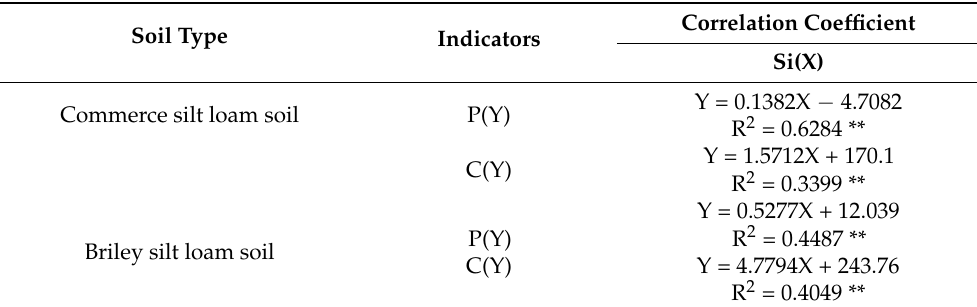
Table 1. Correlation analysis between soil available Si, water soluble P, and water soluble C after Si source amendments (1 and 3% application rate).